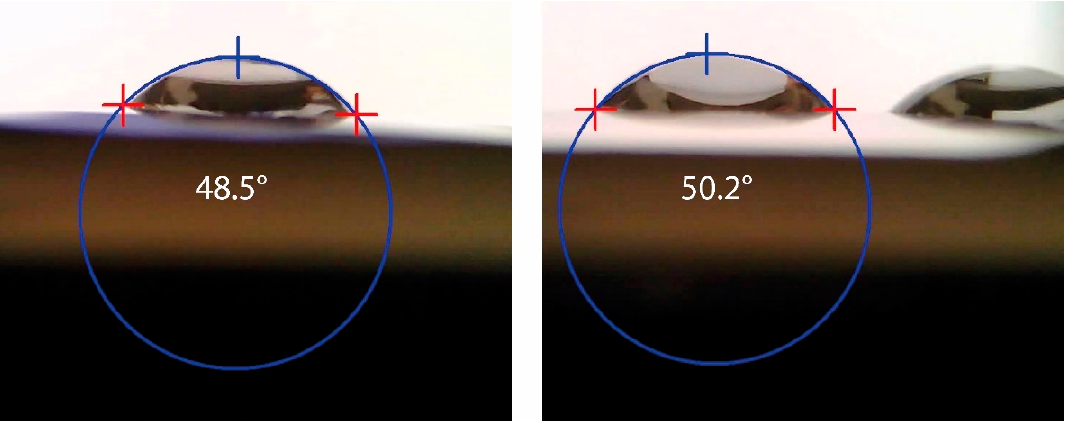
Figure 4. Water droplets on the surface of the tested sample. The value of contact angle evaluated is given.